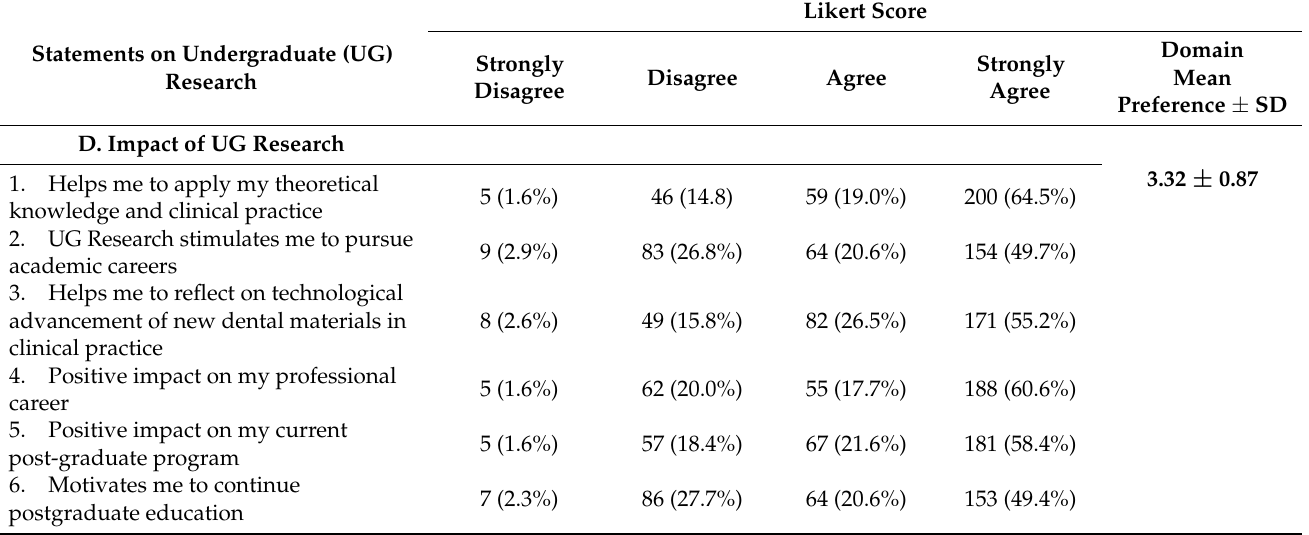
Table 5. Impact of UG